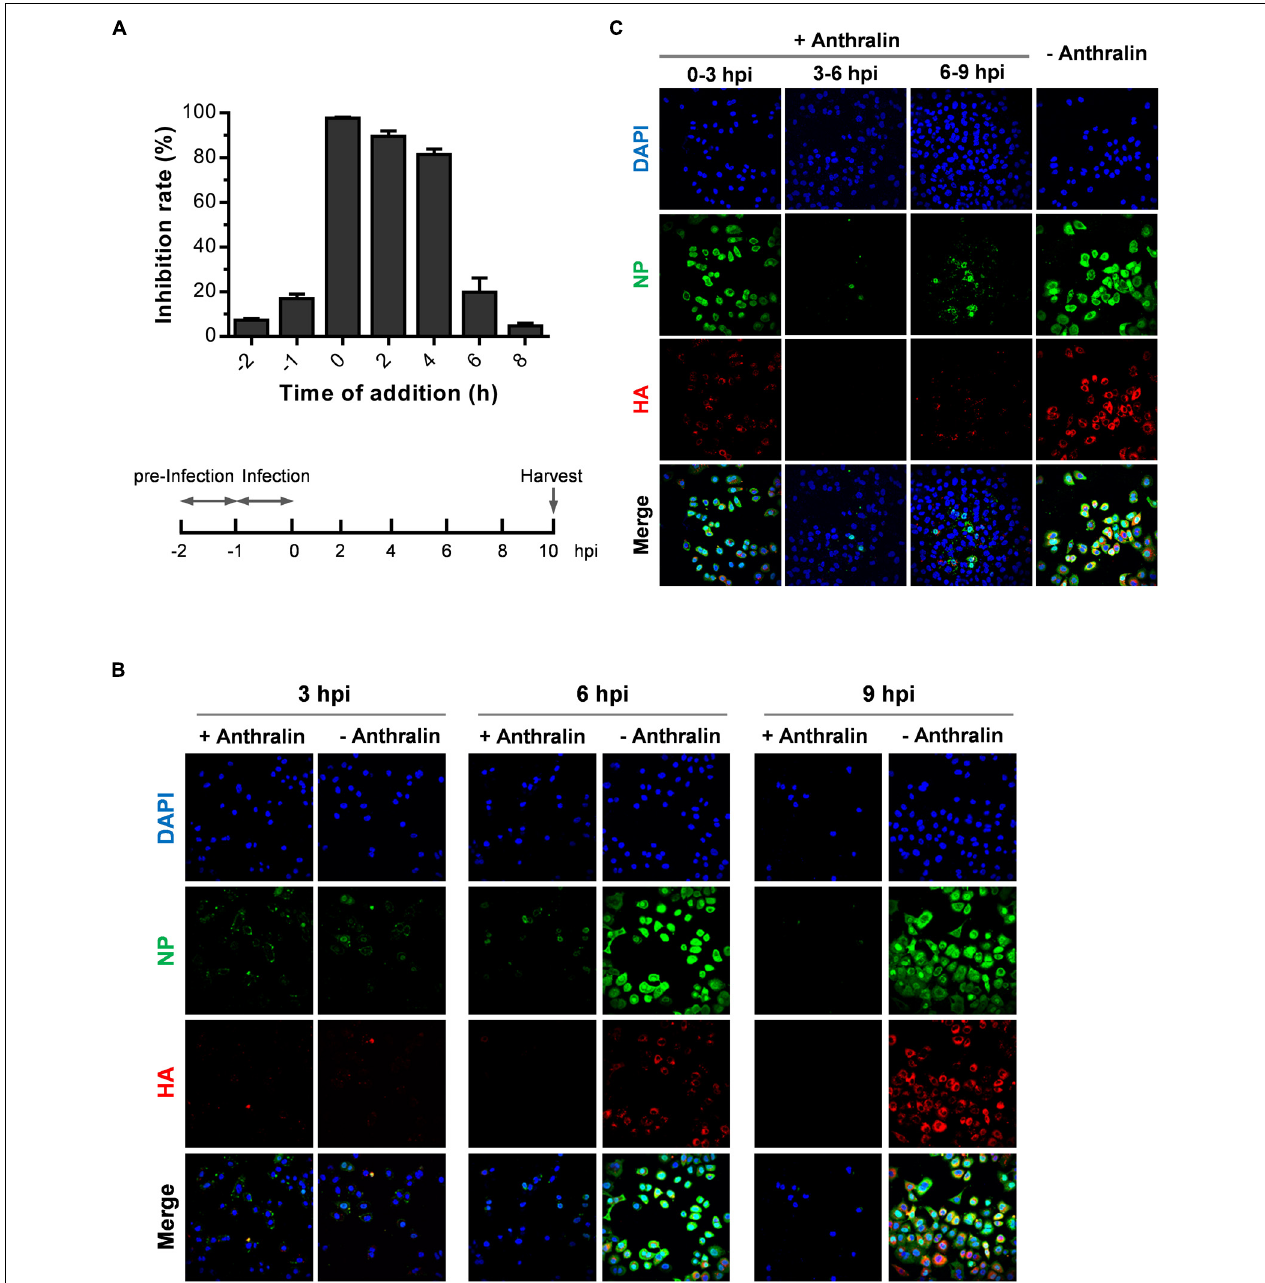
FIGURE 2 | Anthralin inhibits the mid-phase of the influenza life cycle. (A) MDCK cells were precooled at 4 ◦ C for 30 min. (i) Cells were incubated with anthralin at 4 ◦ C for 1 h before infected with PR8 virus at 4 ◦ C for 1 h, the NA activities in the supernatants were measured 10 hpi. (ii) Cells were incubated with virus and anthralin at 4 ◦ C for 1 h, the NA activities in the supernatants were measured 10 hpi. (iii) Time-of-addition assay: Cells were infected with PR8 virus at an MOI of 0.01 at 4 ◦ C for 1 h, anthralin was added at an interval of 2 h after virus adsorption. The NA activities in the supernatants were measured 10 hpi. (B,C) A549 cells were precooled at 4 ◦ C for 1 h, and infected with PR8 virus at an MOI of 5 at 4 ◦ C for 1 h to synchronize the infection. The infected cells were treated with anthralin at 37 ◦ C until being fixed at 3, 6, and 9 hpi., respectively, (B) , or were treated with anthralin at different time periods and the cells were fixed 9 hpi (C) , and stained with anti-NP, HA and 4 (cid:48) ,6-diamidino-2-phenylindole (DAPI).